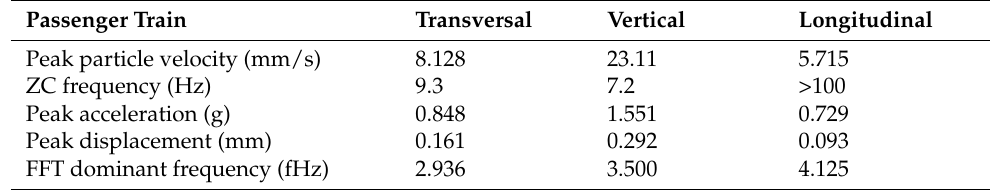
Table 7. Calibrated measurement results from Minimate Plus measuring equipment for Freight